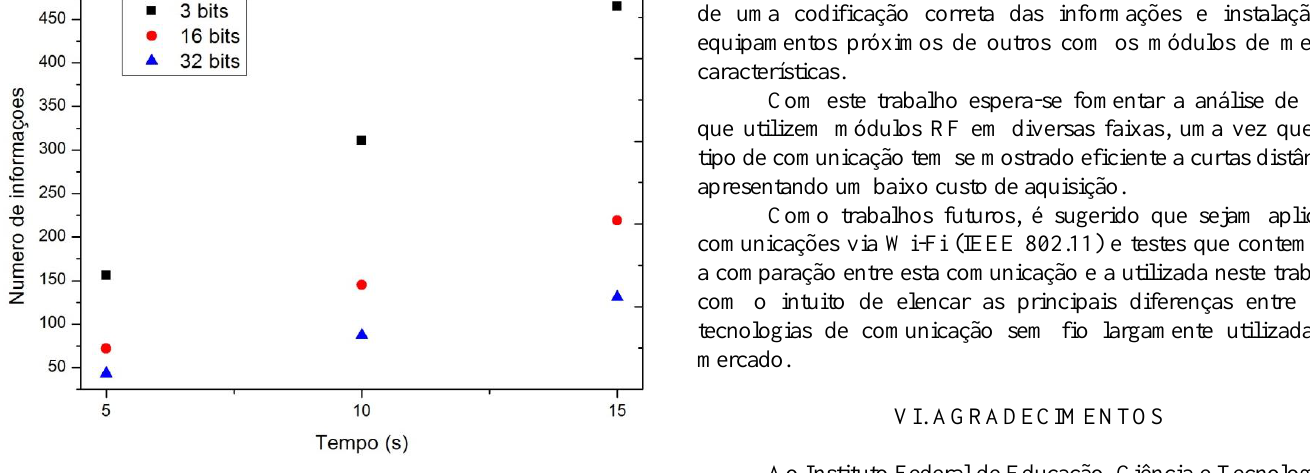
Figura 14: Gráfico do número de informações no tempo. Fonte: Autores,